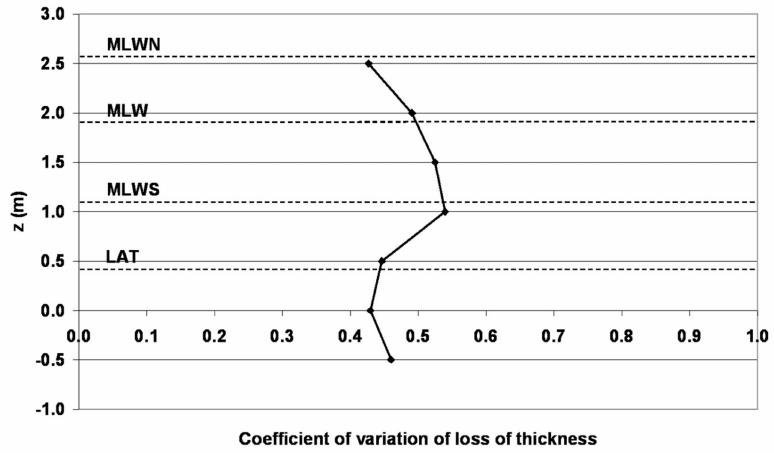
Figure 10. Coe ffi cient of variation of loss of thickness according to